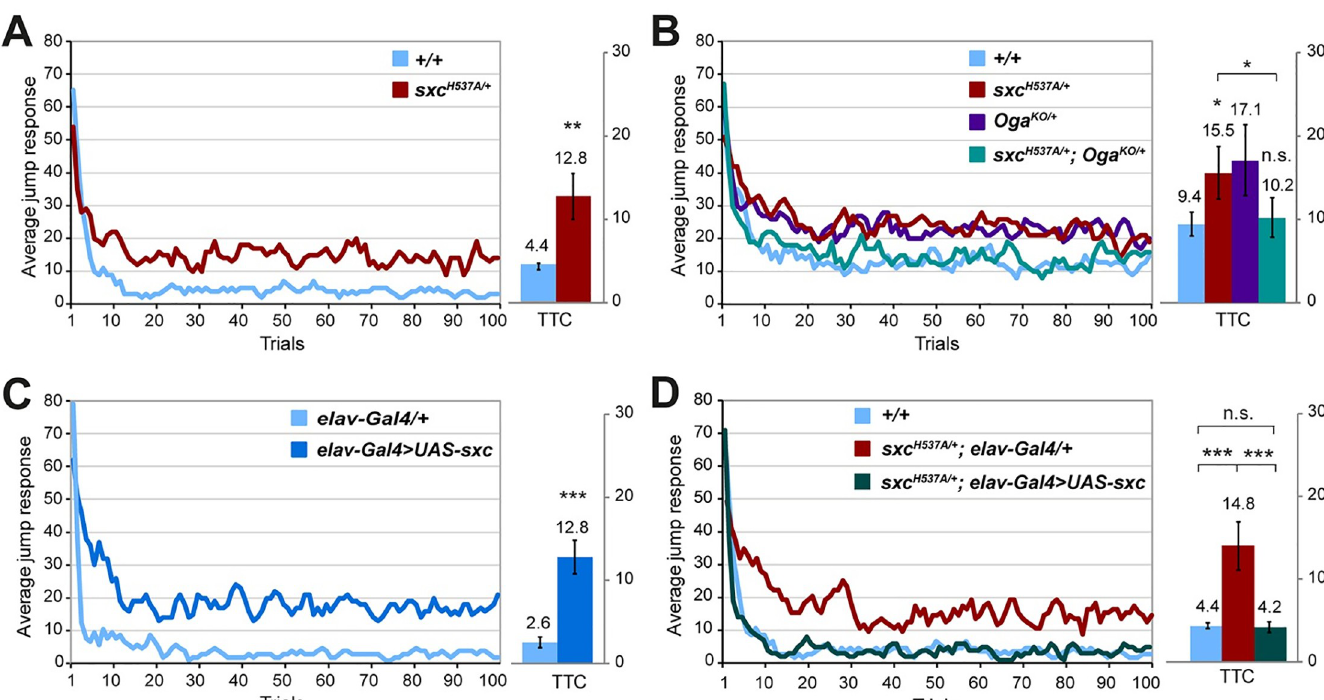
Fig 1. Catalytic activity of O-GlcNAc transferase in neurons is required for habituation learning. Jump responses were induced by 100 light-off pulses with 1 s intervals between pulses. The jump response represents the % of jumping flies in each light-off trial. The mean number of trials that flies needed to reach the no-jump criterion (Trials To Criterion, TTC) ± SEM is also shown. (A) Defective habituation of sxc H537A/+ flies (N = 59, mean TTC ± SD: 12.8 ± 6.7 p = 0.001, in red) compared to their respective genetic background control flies ( +/+ , mean TTC ± SD: 4.4 ± 0.9, N = 61, in blue). �� p < 0.01, based on lm analysis. (B) Habituation defect of sxc H537A/ H537A/+ ; Oga KO/+ flies (N = 70, mean TTC ± SD: 10.1 ± 5.9, + flies (N = 72, mean TTC ± SD: 15.5 ± 7.8 p adj = 0.045, in red) is corrected by removing one Oga allele in sxc p adj = 0.024, in cyan) to the level of control flies (N = 72, mean TTC ± SD: 9.4 ± 3.5, p adj = 0.677, in blue). Habituation of Oga KO/+ flies (N = 76, mean TTC ± SD: 17.1 ± 10.4, in purple) is slower but not significantly different from the control flies ( p adj = 0.467). (C) Defective habituation of elav-Gal4 > UAS-sxc flies (N = 55, mean TTC ± SD: 12.8 ± 4, p adj = 3.89x10 -12 , in dark blue) compared to control elav-Gal4/+ flies (N = 38, mean TTC ± SD: 2.6 ± 1.3 in light blue). (D) Habituation defect of sxc H537A/+ ; elav-Gal4/+ flies (N = 40, mean TTC ± SD: 14.6 ± 6, p adj = 4.92x10 -12 , in red) is corrected by selective expression of UAS-sxc in neurons ( sxc H537A/+ ; elav- Gal4 > UAS-sxc , N = 43, mean TTC ± SD: 4.2 ± 1.3, p adj = 8.94x10 -7 , in green), to the level of the genetic background control flies ( +/+ , N = 65, mean TTC ± SD: 4.4 ± 0.9, p adj = 0.68, in blue). � p adj < 0.1, ��� p adj < 0.001, n.s. not significant, based on lm analysis with Bonferroni-Holm correction for multiple comparisons. A complete list of p-values and summary statistics is provided in S3 Table .